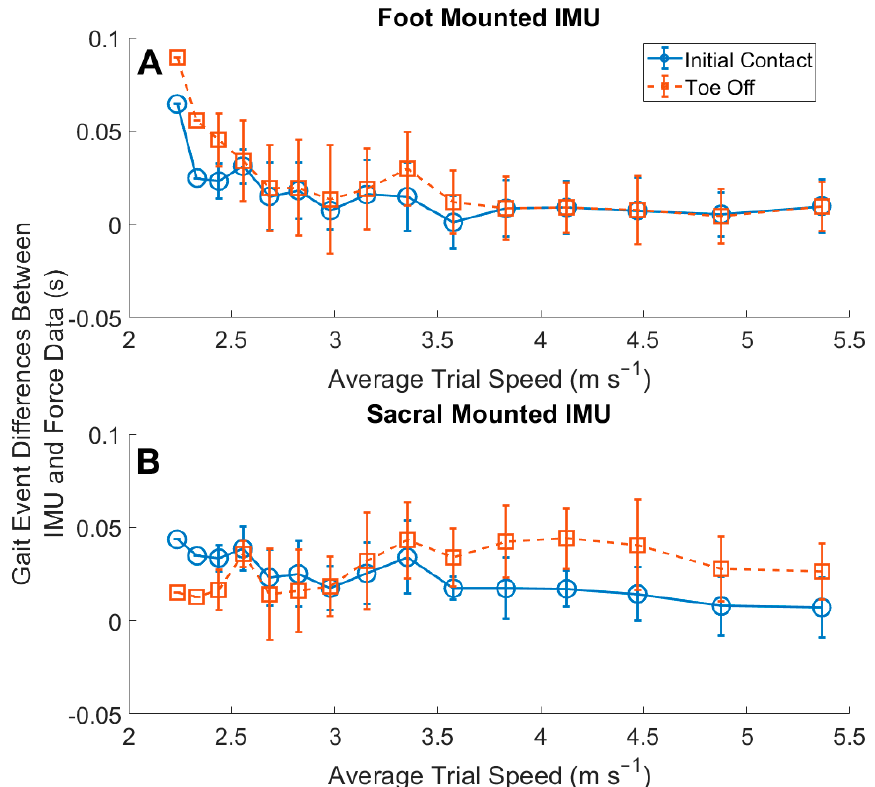
Figure 4. Time differences in the identification of gait events between measured forces and estimated IMU gait events: ( A ) results from foot-mounted IMU; ( B ) results from sacral-mounted IMU. Negative time differences indicate that the IMU-estimated gait event occurred prior to the measured gait event. The identification of TO sacrum had larger error rates due to the temporal windowing of the data, and the wider range of speeds used than previous work.